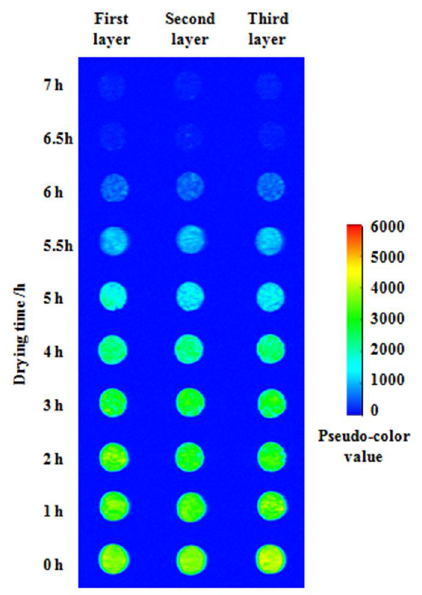
Figure 8. Pseudo-color picture of the soybean dregs during the drying process.